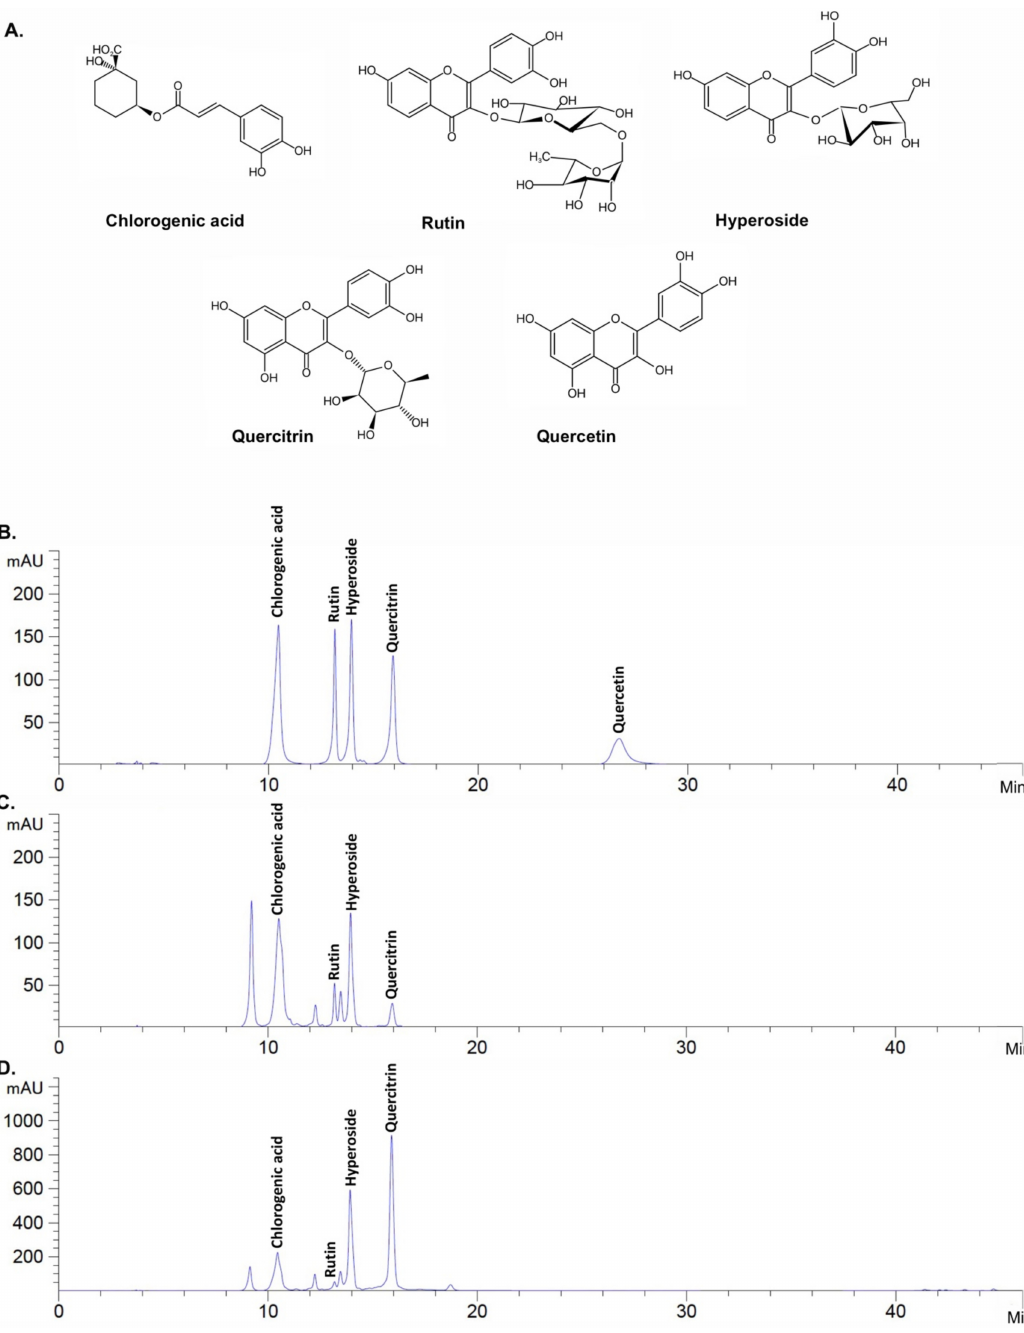
Figure 1. HPLC profile of H. cordata extracts. Chemical structure of active compounds determined in this study (chlorogenic acid; rutin; hyperoside; quercitrin; and quercetin, respectively) ( A ). HPLC chromatogram of active compound standards according to their retention time at a concentration of 50 µ g/mL for each standard ( B ). HPLC chromatogram of HcEE at 2500 µ g/mL ( C ). HPLC chromatogram of HcEA at 2500 µ g/mL ( D ). The HPLC chromatograms were evaluated using a reversed-phase C18 column. The mobile phase was composed of mobile phase A (0.1% CH 3 COOH) and mobile phase B (MeCN) under a gradient condition. The detection wavelength was 330 nm. The flow rate was set to 0.8 mL/min. 2.3. H. cordata Thunb. Extracts Displayed No Cytotoxicity on Human Dermal